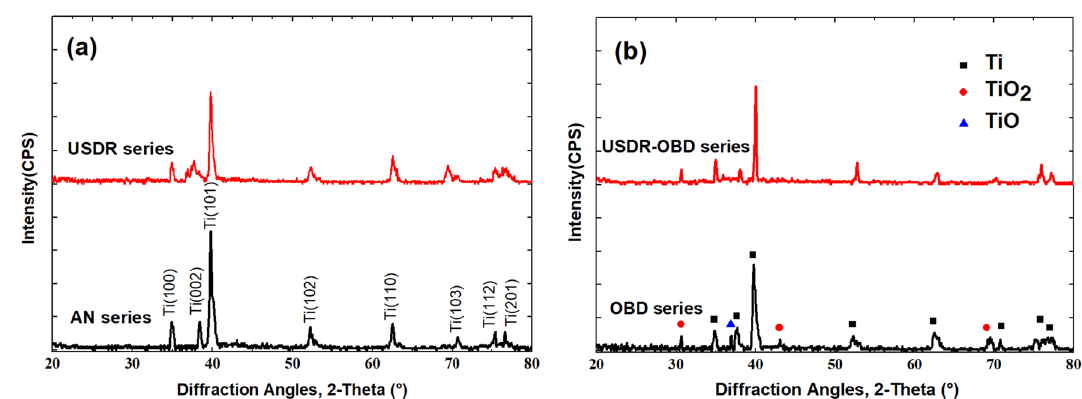
Figure 3. XRD patterns of ( a ) AN series, USDR series and ( b ) OBD series, USDR-OBD